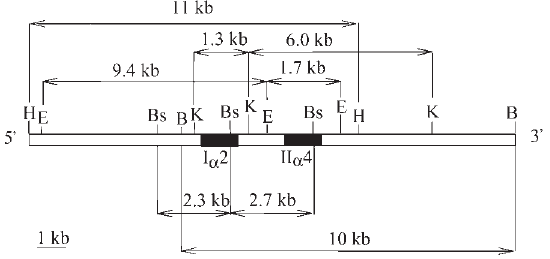
Figure 5 - Schematic representation of the restriction endonuclease map for13sitesintheriverbuffalo α -globingenefromBBhemoglobinpheno- types. B = Bam HI; Bs = Bst EII; E = Eco RI; H = Hind III; K = Kpn